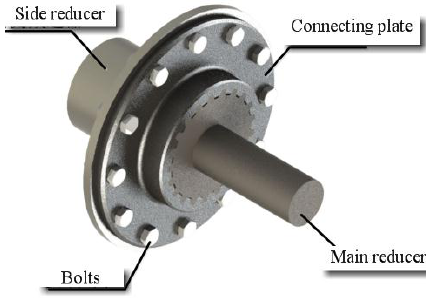
Figure 22. The use conditions of the connecting plate.